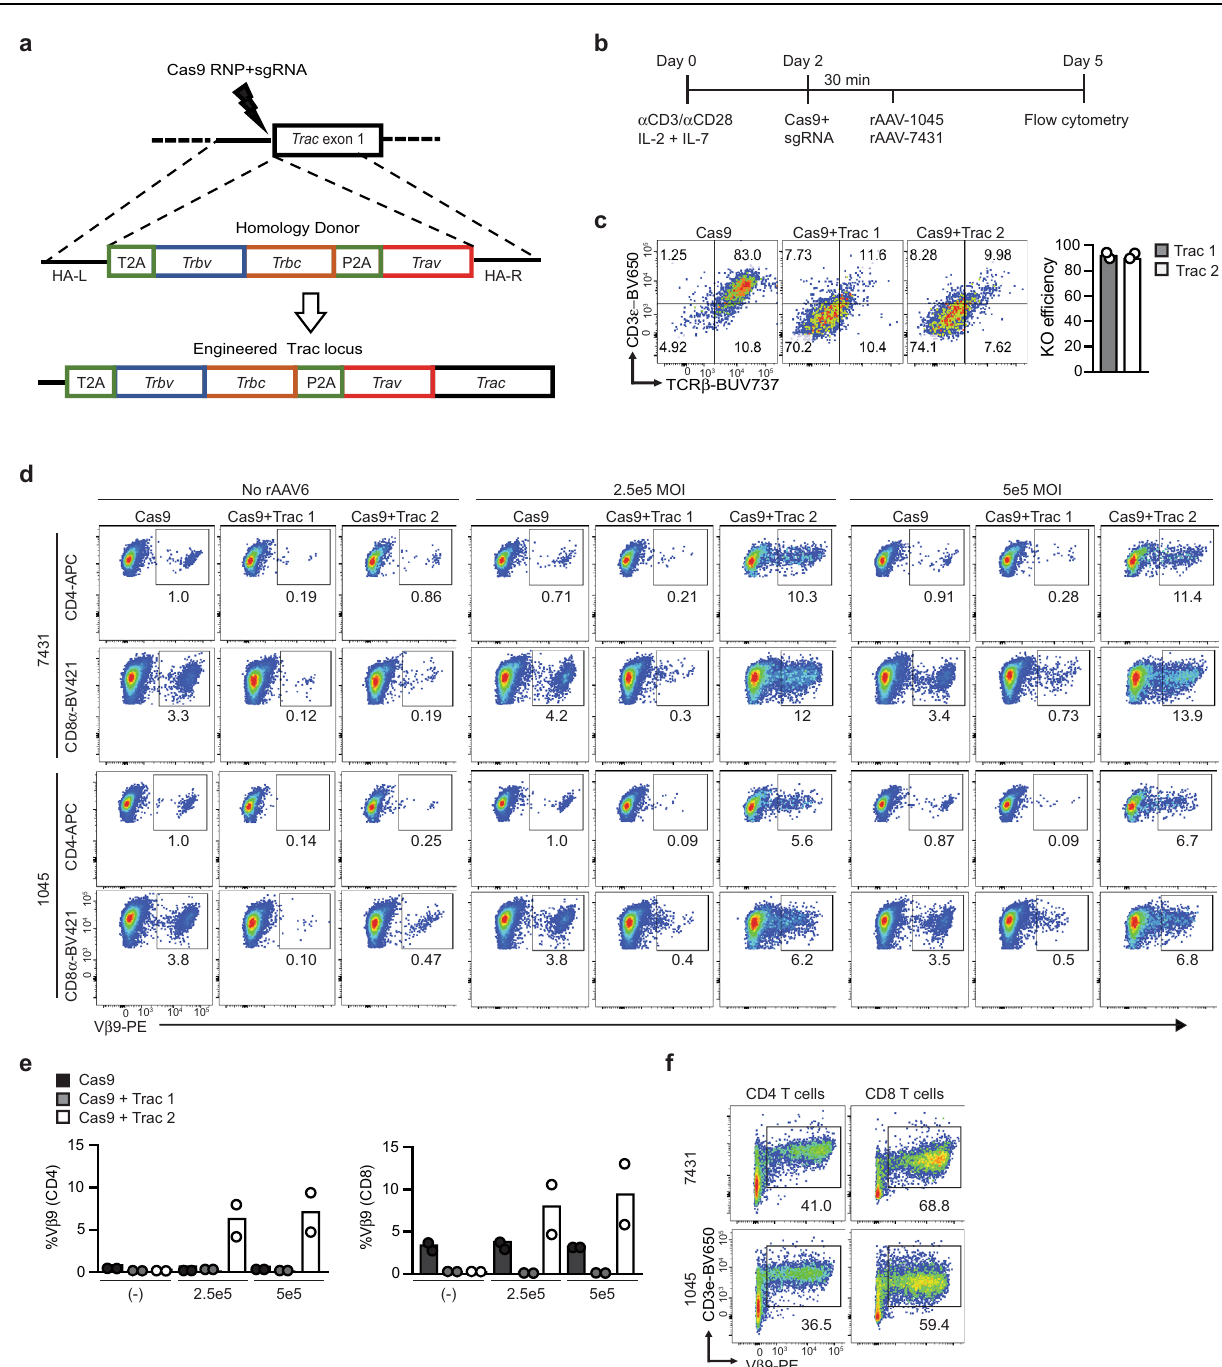
Fig. 1 | Targeting Msln-speci fi c TCRs to Trac in primary murine T cells. a Schematic of TCR targeting to murine Trac . sgRNAs targeting the region upstream of Trac exon 1 were designed. Codon optimized 1045 or 7431 TCR β variable(V),TCR β Constant(C)andTCR α V,linkedbyaself-cleavingP2Ais fl anked byleftandrighthomologyarms(HA-L,HA-R)andencodedbyrecombinantadeno- associated virus (rAAV) serotype 6. b Protocol for testing TCR targeting using CRISPR/Cas9 and rAAV. Polyclonal B6 splenocytes were activated with anti-CD3+ anti-CD28, IL-2 and IL-7. Two days after T cell activation, splenocytes were elec- troporated with Cas9 RNP complexed to Trac -speci fi c sgRNAs, followed by